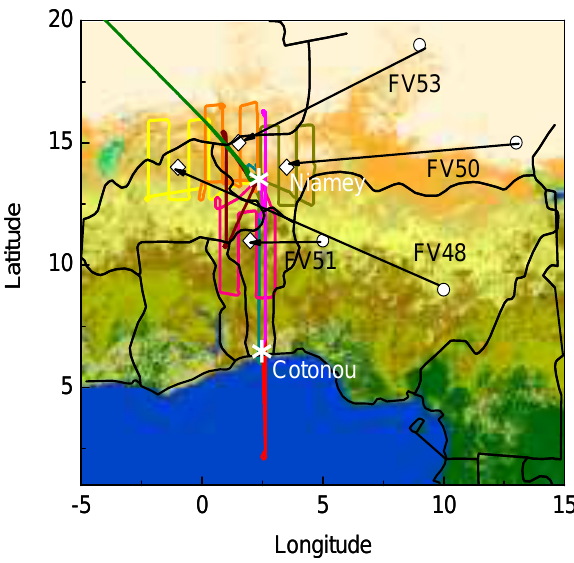
Fig. 1. Explored area during AMMA SOP 2a2. The map reflects the land-surface coverage. Light yellow indicate sahelian type surface. Orange denotes semi-desert region. Light green indicates savanna. Dark green stands for tropical forest. Flights tracks performed by the F-F20 are displayed. The round markers are the locations where each explored MCS started to develop (called latitude zero). The diamond markers are the position where the MCS was explored. The arrows indicate the trajectory of the MCS.